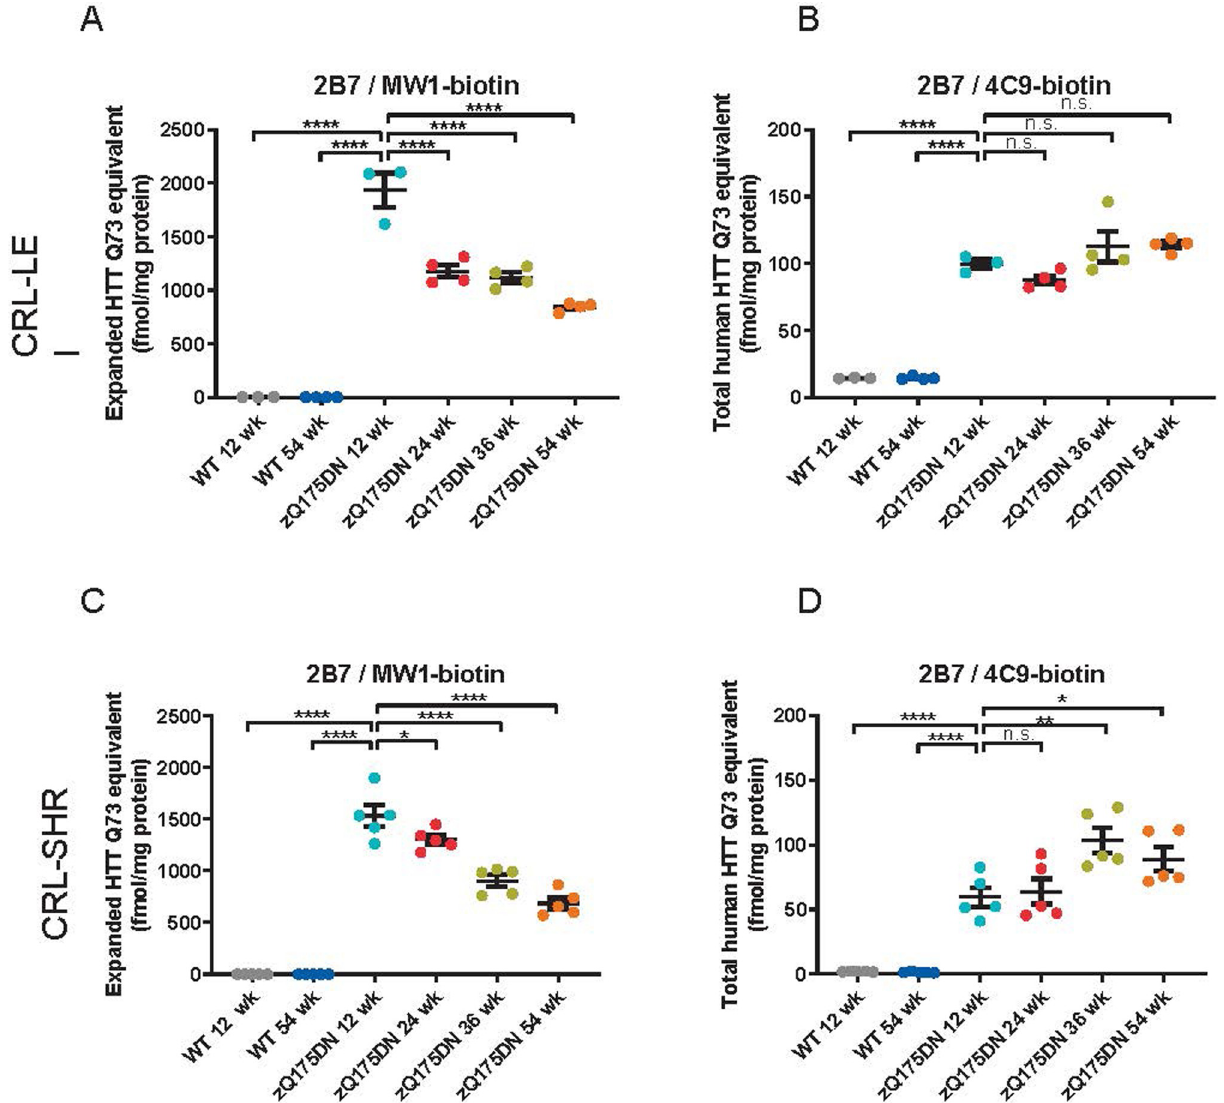
Fig 5. Characterization of HTT protein levels in heterozygous zQ175DN mouse brain over time, as assessed in two independent laboratories in the Netherlands (CRL-LEI, A and B)) and in the U.S. (CRL-SHR, C and D) using the MSD platform. The Q175 allele product was quantitated with two different MSD assays (2B7/MW1 for polyglutamine expanded HTT (A and C) and 2B7/4C9 for total human HTT (B and D)). Please note that the much longer polyglutamine expansion in the sample (zQ175DN has an average of Q200) compared to the reference protein (Q73) leads to an overestimation of the HTT concentration by the assays involving MW1. ���� p < 0.0001; ��� p < 0.001, �� p < 0.01 and � p < 0.05 by Dunnet’s post hoc test following